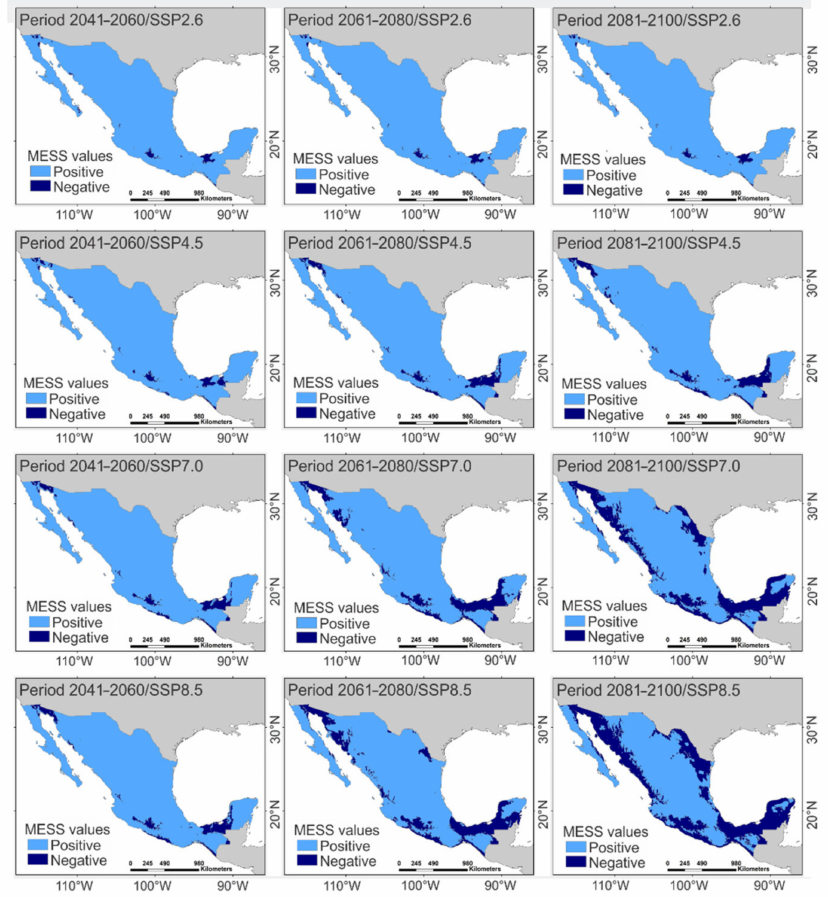
Figure 3. Analysis of multivariate environmental similarity surface (MESS) for each climate change scenario. Negative values indicate unsuitable habitat for the species because of climate change and positive values specify habitats that will concur with the climatic requirements of the